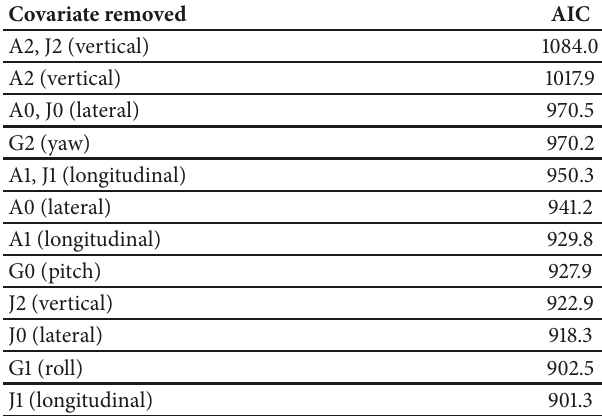
Table 2: Akaike information showing the relative importance of the various sensor data on the participants’ performance. Higher AIC reflects a higher importance of the corresponding covariate.